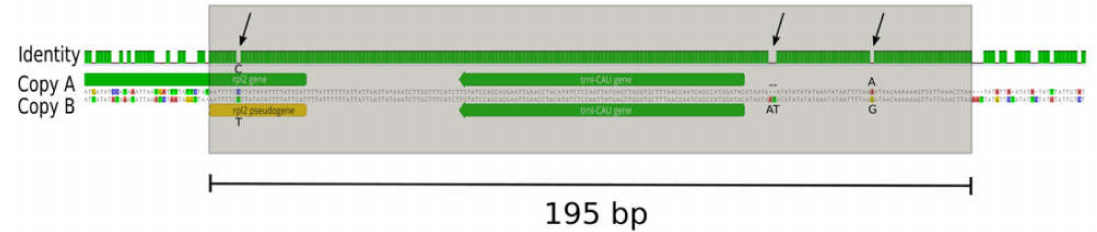
Figure 3. Prosopanche americana trn I-CAU repeat region. Alignment of the two trn I-CAU repeat copies highlights high sequence identity (green identity bar) over 195 bp with only four nucleotide di ff erences (arrows pointing to gaps in identity graph and nucleotide di ff erences highlighted by color and nucleotide code in sequence alignment). The trn I-CAU gene is fully contained within the repeat whereas only 25 bp of the rpl 2 gene start fall within repeat borders. Contrary to copy B, which stays with a truncated rpl 2 pseudogene, copy A is preceded by the complete rpl 2 ORF of Prosopanche americana